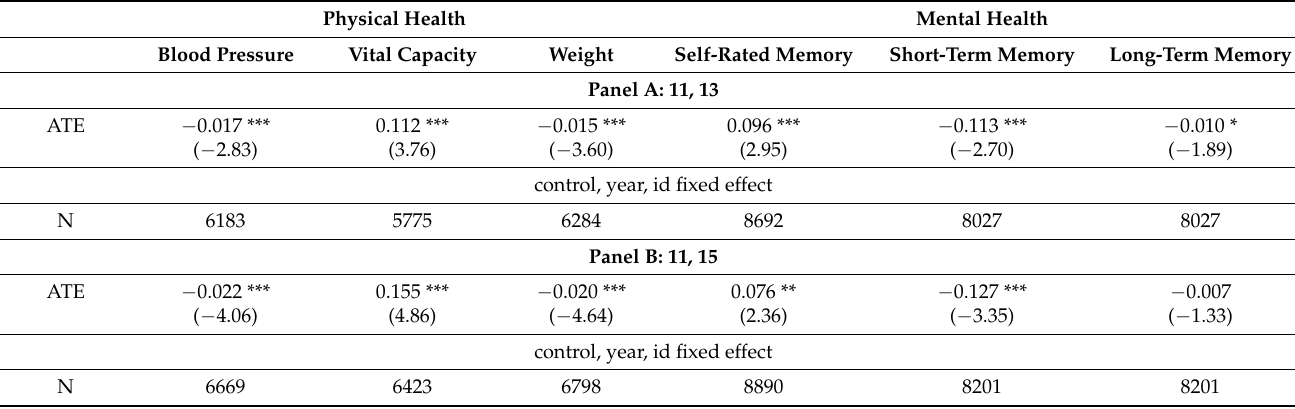
Table 4. Semi-parametric difference-to-difference (SDID)